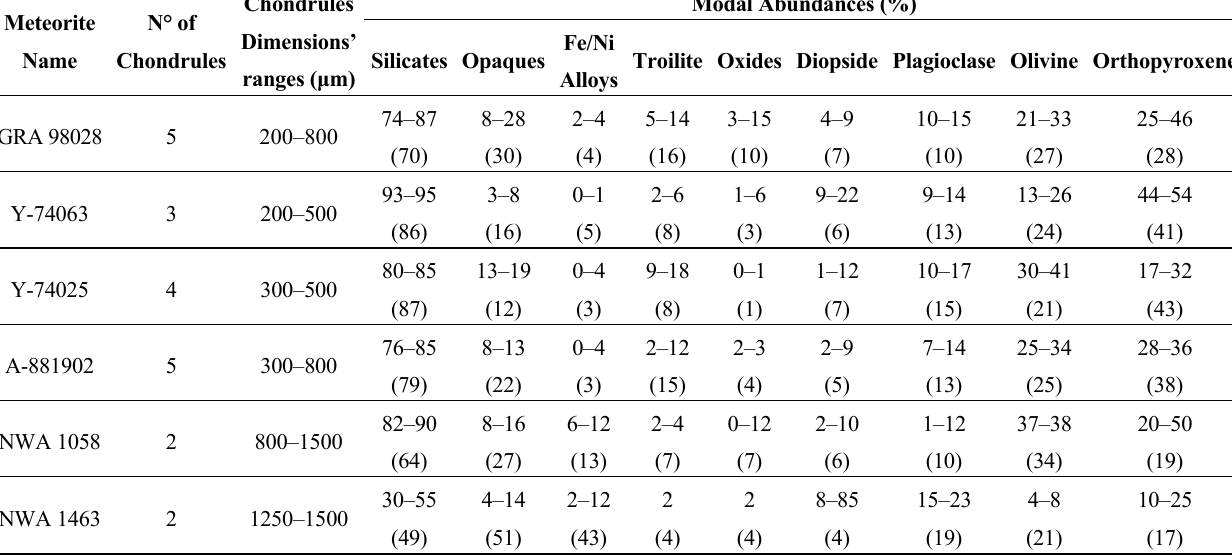
Table 4. Modal analysis of chondrule-bearing samples; chondrule data ranges are compared with the corresponding matrix mean values (in brackets). Opaques are considered as the sum of Fe/Ni alloys, troilite and oxides. See Table 2 for meteorite